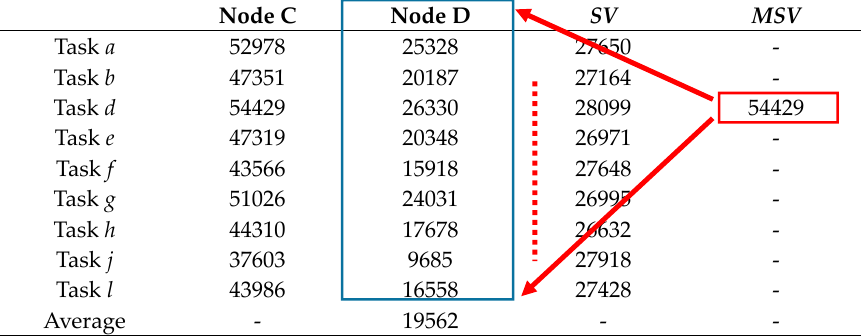
Table 7. Comparison of the MSV values of tasks.